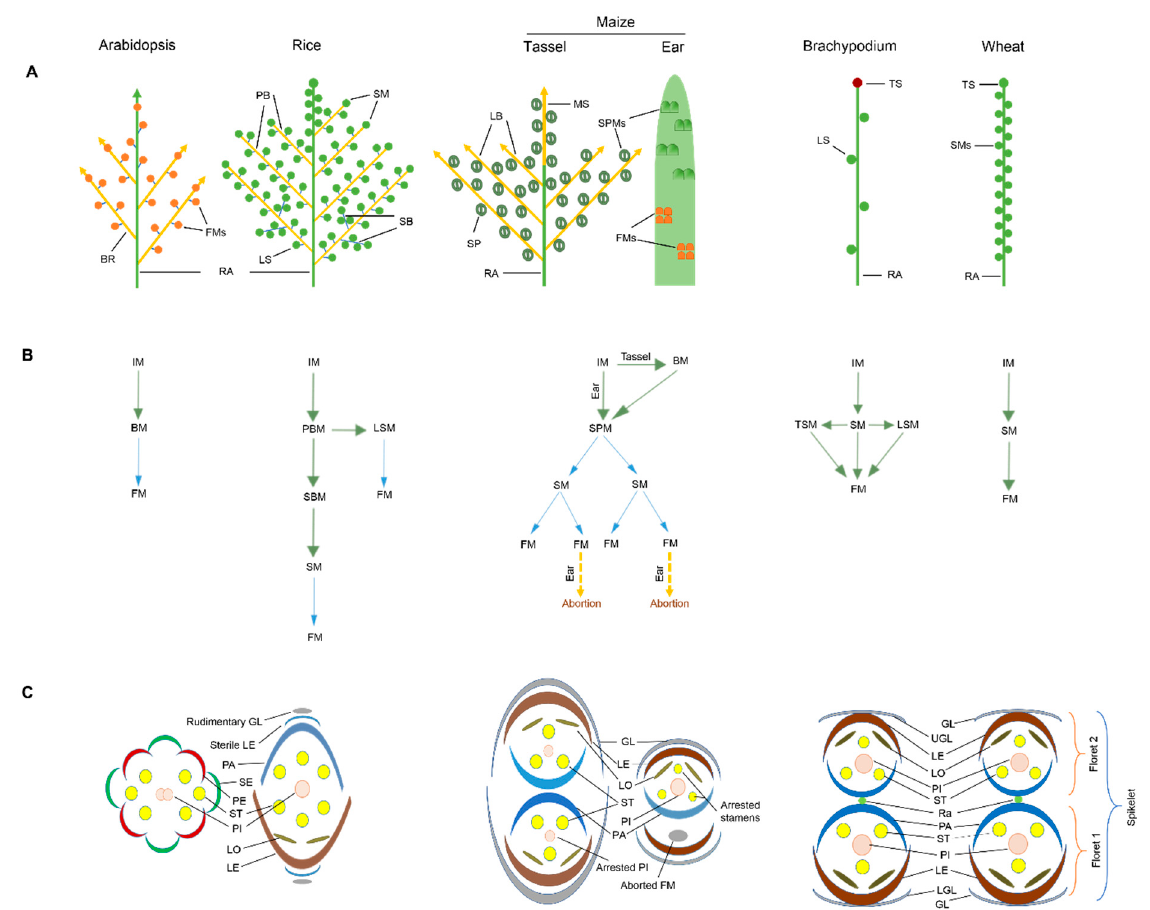
Figure 1. Graphical representation of inflorescences, phase transition and transverse flowers. ( A ) Structural configuration of inflorescence in Arabidopsis, rice, maize, Brachypodium and wheat. Color codes. Green line: rachis; yellow line: primary branch; blue line: secondary branch; green circles: spikelet / spikelet pair meristems; maroon circle / oval: terminal spikelet; orange circle: floral meristems. ( B ) Regulation of meristem transition in Arabidopsis, rice, maize, Brachypodium, and wheat. Green arrow: multiple meristems formation; blue arrow: single meristem formation; orange dashed arrow: abortion of floral meristems. ( C ) Schematic representation of transverse spikelet / flower. Color codes: Blue: palea; dark orange: lemma; gold: lodicules; green: sepal; green circle: rachis; gray: glume; pink: pistil; red: petal; yellow: stamen. Abbreviations: BR: branch; BM: branch meristem; FM: floral meristem; GL: glume; IM: inflorescence meristem; LE: lemma; LO: lodicule; LS: lateral spikelet; LSM: lateral spikelet meristem; PA: palea; PB: primary branch; PE: petal; PI: pistil; PBM: primary branch meristem; RA: rachis; Ra: rachilla; SB: secondary branch; SE: sepal; SBM: secondary branch meristem; SM: spikelet meristem: SPM: spikelet pair meristem; ST: stamen; TS: terminal